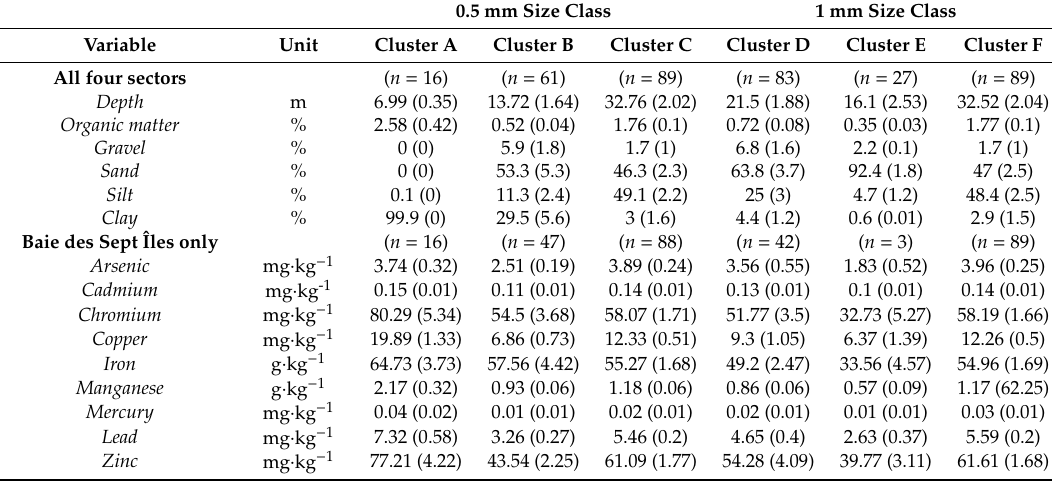
Table 4. Mean values (and standard error) of habitat parameters calculated with stations belonging in the groups defined by the hierarchical agglomerative clustering for the 0.5 mm and the 1 mm size classes. Only Baie des Sept Îles stations (when available in the cluster) were considered for the calculation of heavy metal concentration averages. n = number of stations considered for the